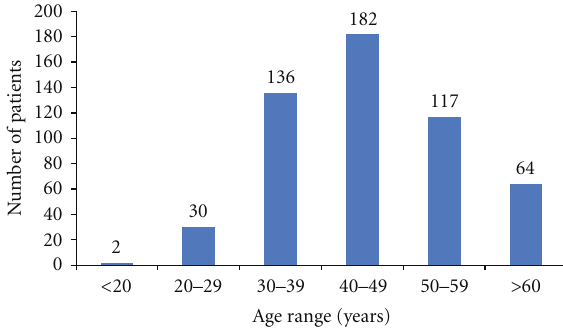
Figure 2: Age range distribution of breast cancer patients.